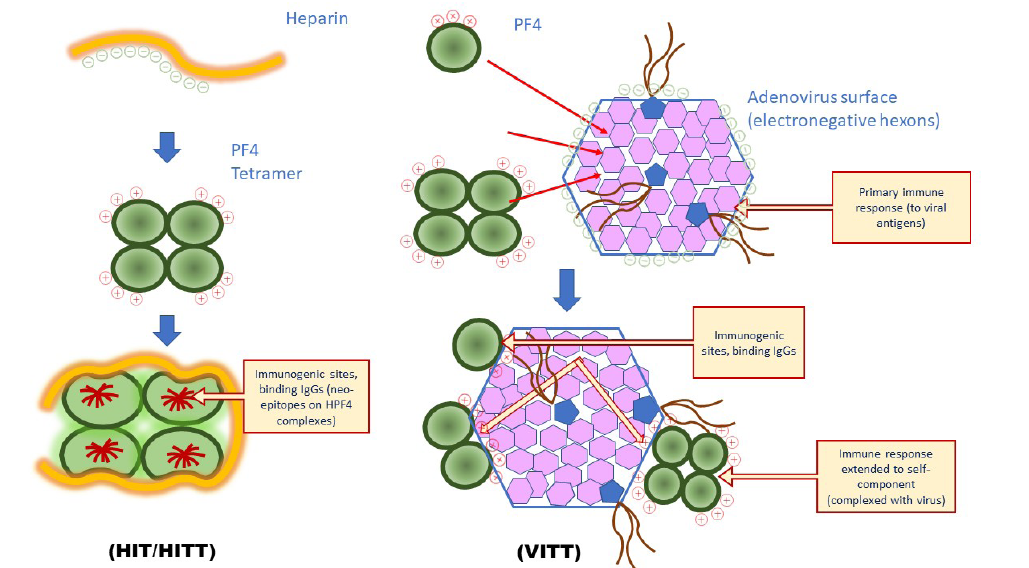
Figure 4. Differences in PF4-dependent immune response involved in HIT or VITT. In HIT binding of PF4 to electronegative polyanions induces the exposure of neo-epitopes, target for antibodies, which can extend to other PF4 epitopes through epitope spreading; in VITT, the ultrarare binding of PF4 to adenovirus vector is the probable stimulus for inducing the generation of antibodies to a restricted structure located at the PF4 positive amino acid sequence, involved in the binding to electronegative hexons: antibodies first target these hexons before the reaction is extended to the associated PF4 sequence through epitope spreading. HITT: HIT with